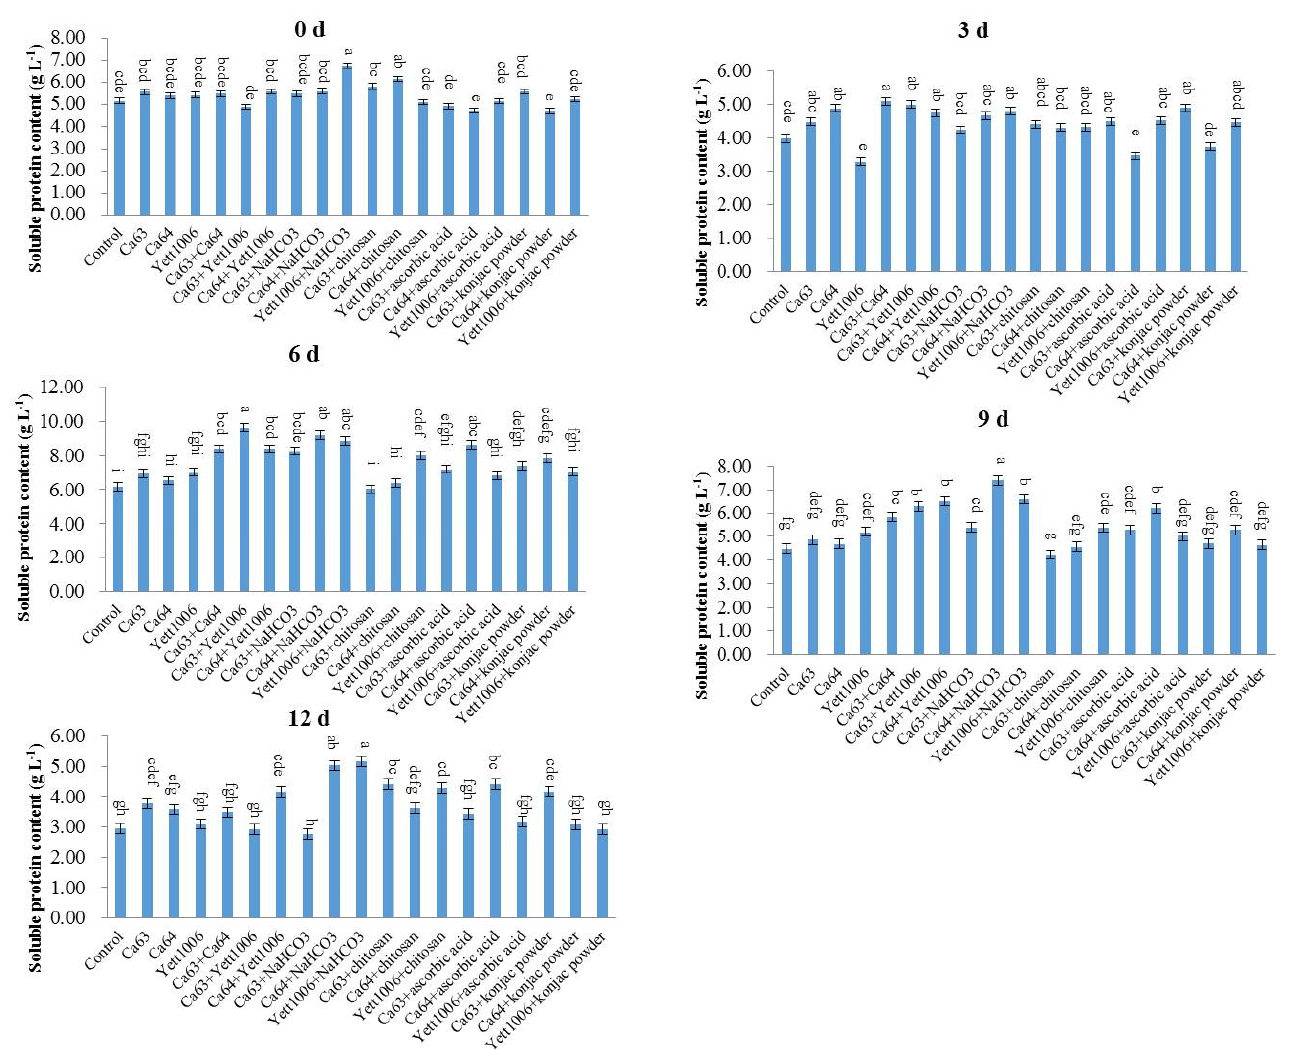
Figure 8. Evaluation of soluble protein content in snap beans between different treatments. Error bars represent the standard deviations of means ( n = 3). On the bars, the small letters indicate a significant difference in the treatment according to Duncan’s multiple difference test ( p < 0.05).